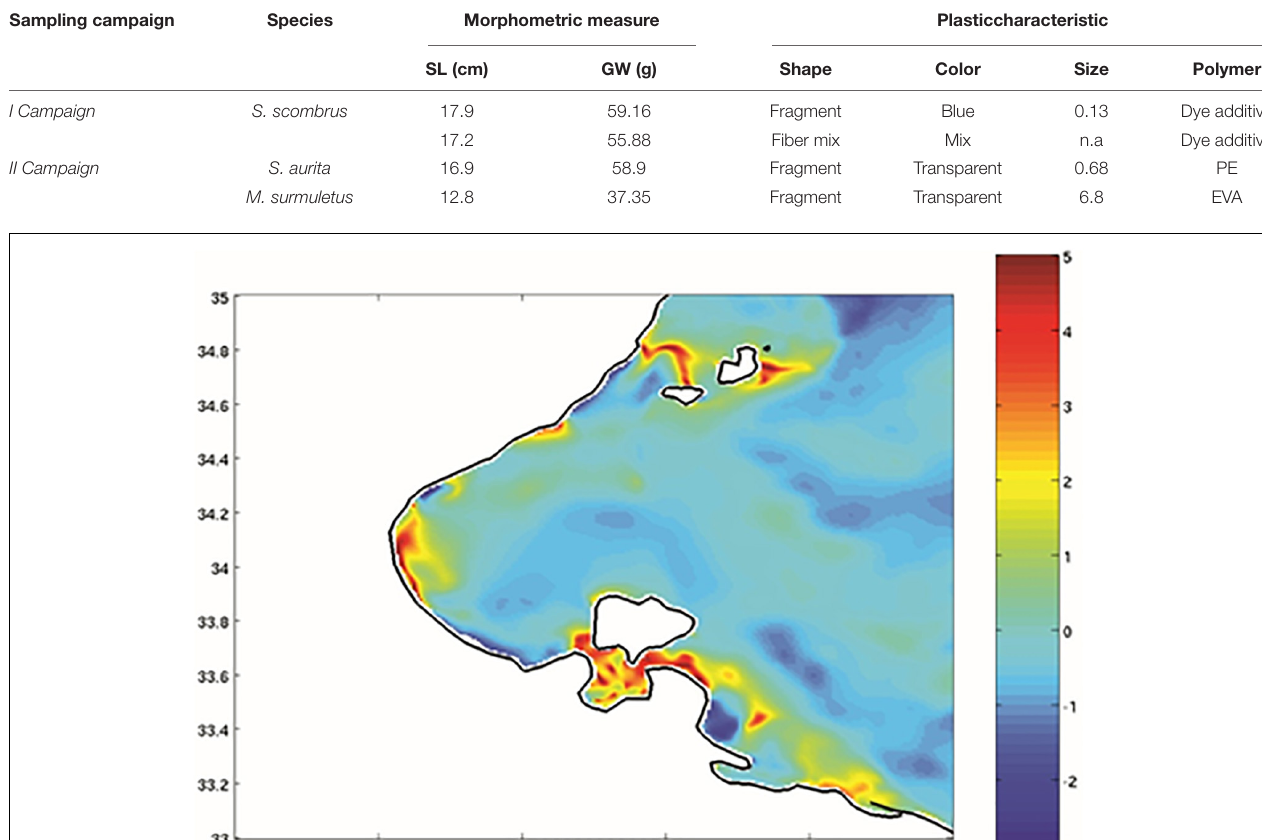
TABLE 4 | Seafood species with ingested MPs, morphometric measure (standard length SL and gutted weight GW) and plastic characteristics (shape, color, size, polymer). n.a, data not available. Sampling campaign